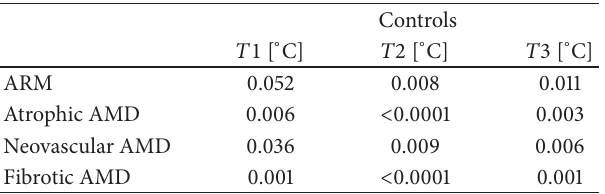
Table 3: 𝑃 values calculated from unpaired t -test carried out between controls and each AMD